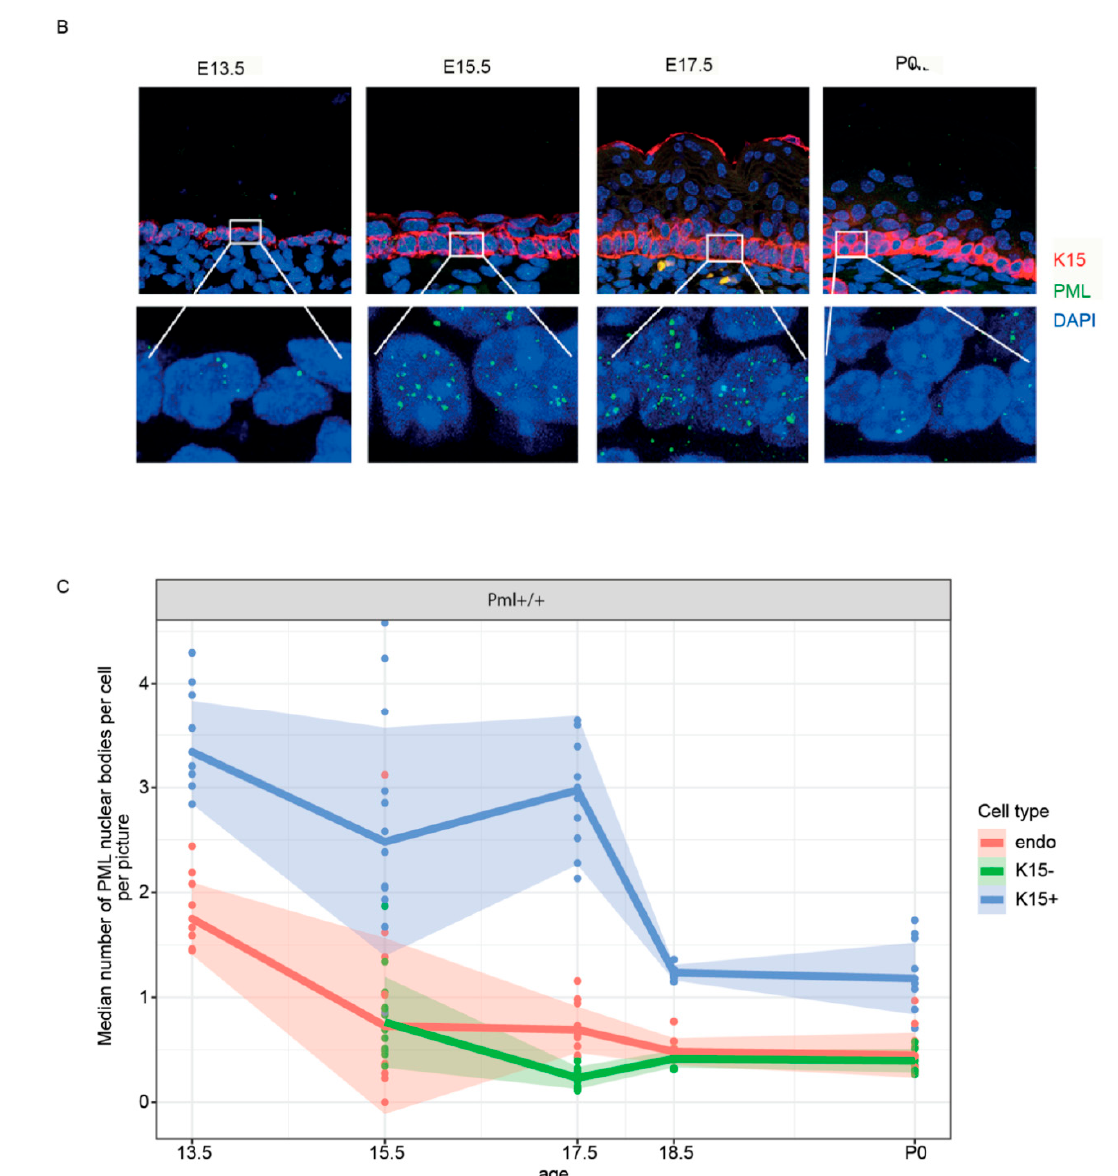
Figure 3. Elevated levels of PML bodies in basal epidermal cells during embryogenesis. ( A ) Schematic of epidermal cell layers during embryonic and postnatal development. Structural layers of epidermis at E13.5, E15.5, E17.5, and postnatal day (P) 0 is depicted. PML nuclear bodies are predominantly observed in the basal cell layer during embryogenesis. ( B ) Paraffin embedded sagittal sections obtained from developmental stage E13.5, E15.5, E17.5, and P0 were immunofluorescence (IF) labeled using antibodies against K15 (red) and PML NB (green). 4 ′ ,6-diamidino-2-phenylindole (DAPI) is shown in blue. The images are projections of multiple confocal Z-stacks. White rectangles highlight zoom-in of basal cells containing PML. ( C ) Quantitative assessment of PML bodies in different layers of epidermis obtained from E13.5, E15.5, E17.5, E18.5, and P0 mice. Each data point represents the average of PML bodies per cell from a single embryo.